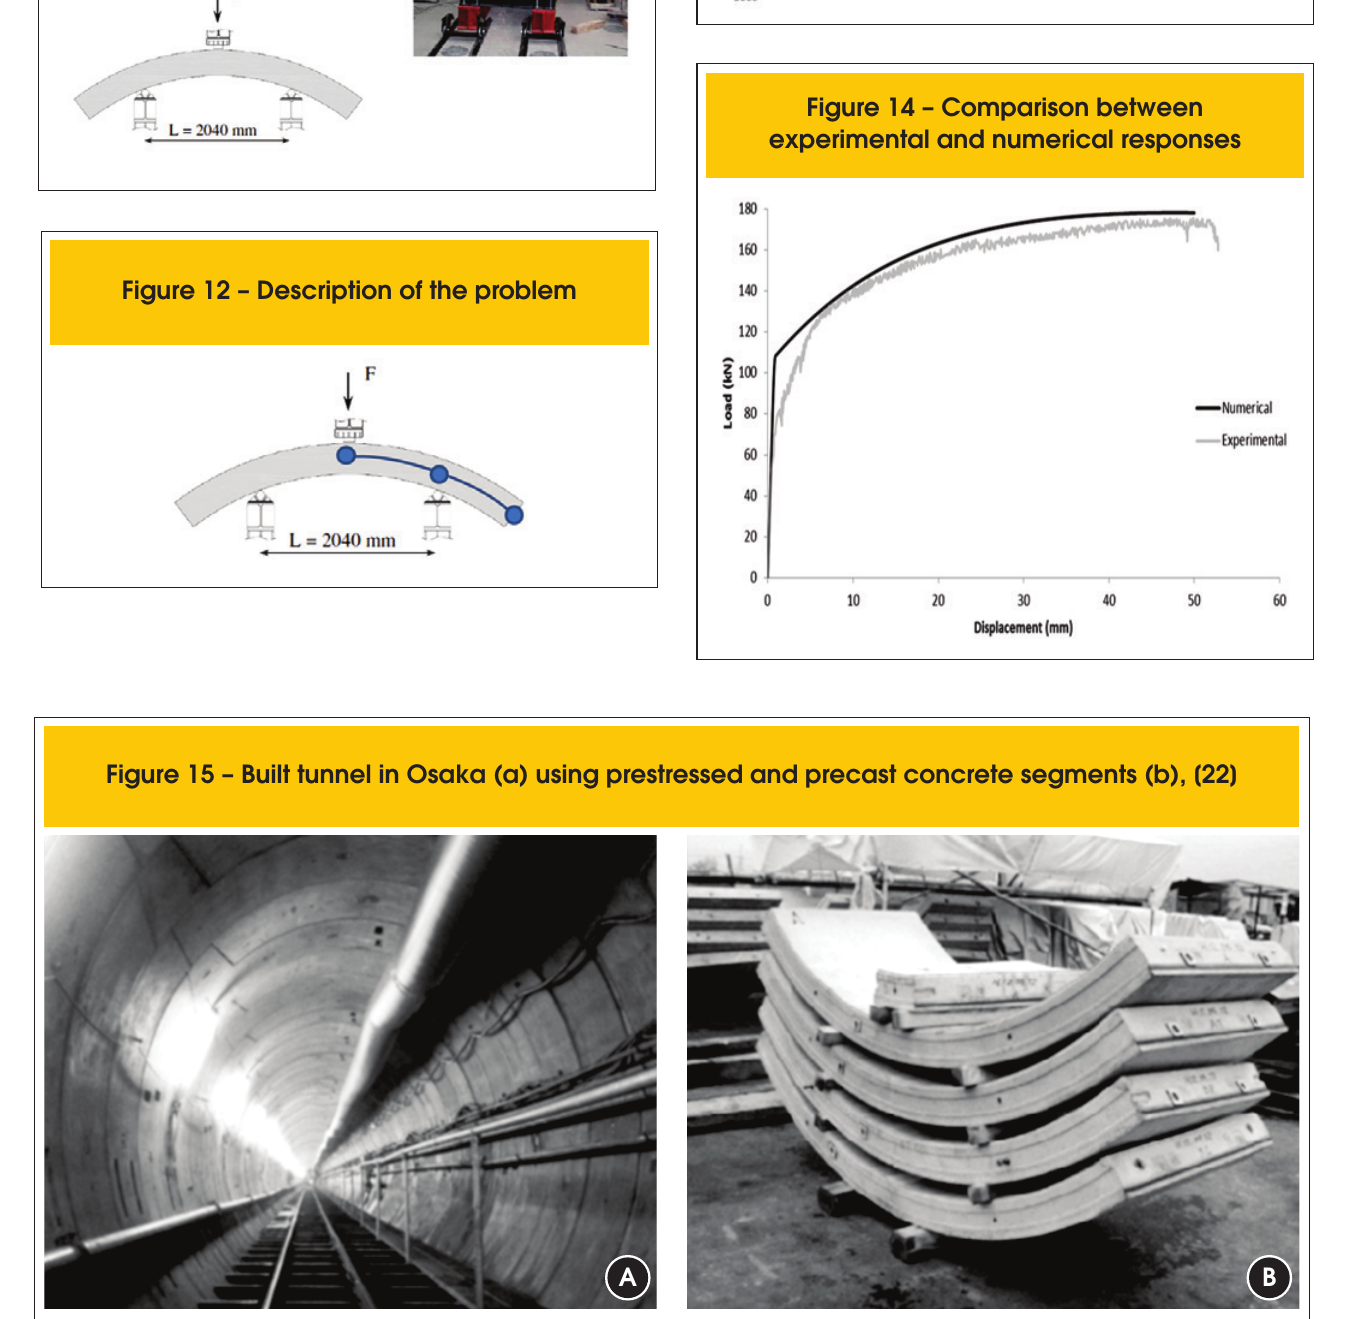
Figure 14 – Comparison between experimental and numerical